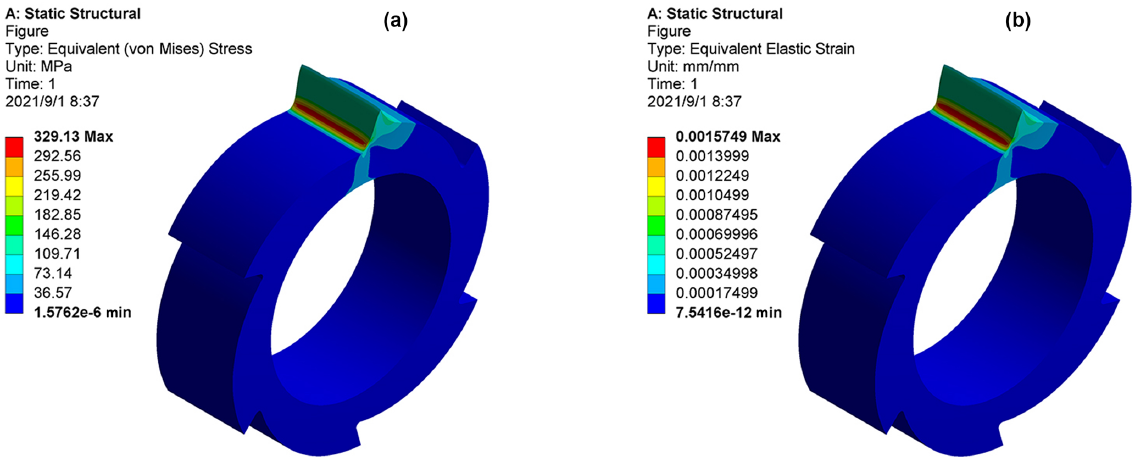
Figure 7. Analysis results under 20000N, with the (a) ratchet stress distribution under 20000N and the (b) ratchet strain distribution under 20000N.